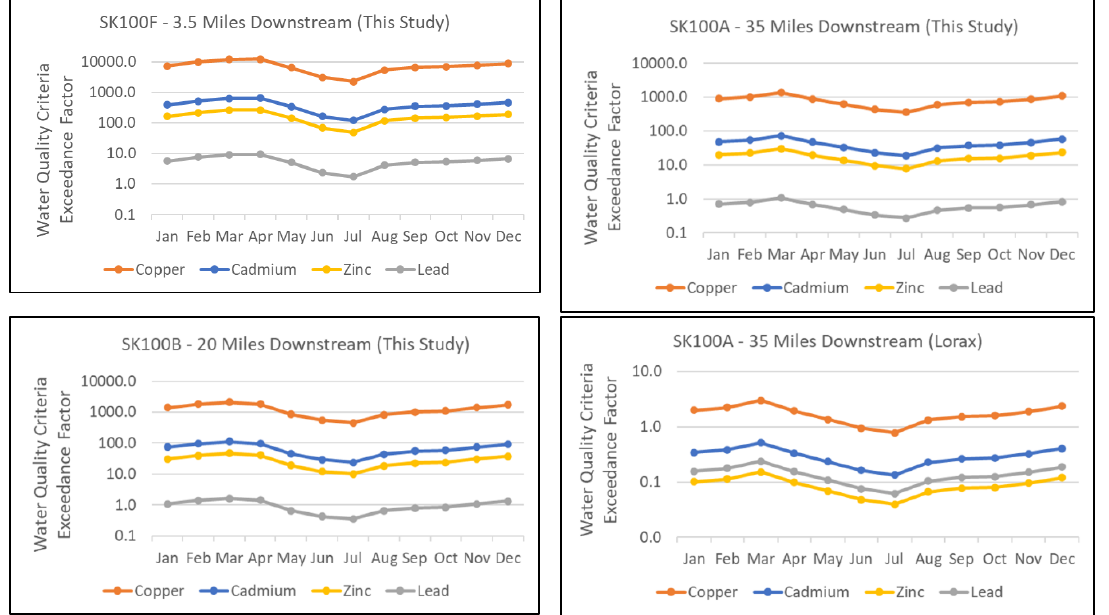
Figure 8. Results for water quality criteria exceedance factors at gaging stations in the South Fork Koktuli River for this study and for the Lorax Environmental [23] study. Note the log scale on the y -axis. At an exceedance factor of 1.0, the predicted stream concentration equals the water quality